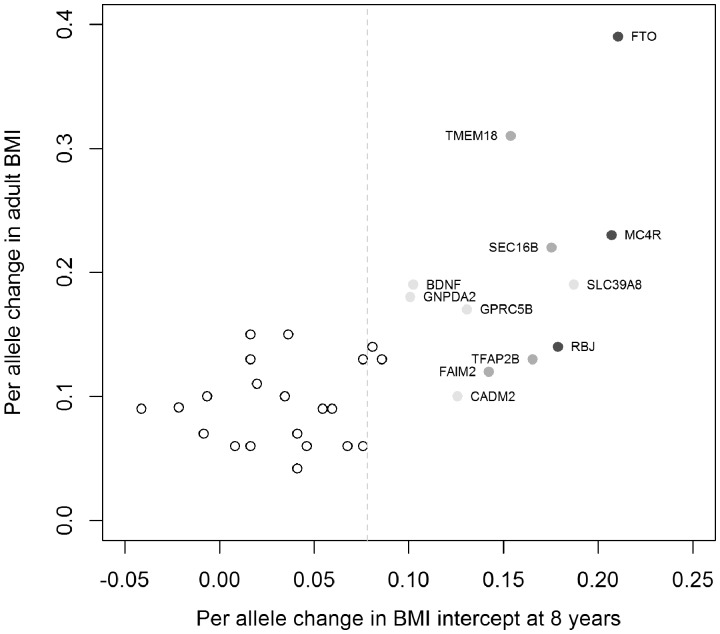
Association results of SNP effect at age 8 years for known adult BMI-associated loci. The y-axis displays the effect size from published meta-analyses8–10 and the x-axis displays the effect size from the meta-analysis presented in this paper of the BMI intercept at age 8. Effect sizes are aligned to the adult BMI-increasing allele. Colour indicates association P-values from the longitudinal model over childhood: dark grey = P < 5 × 10−8, medium grey = 5 × 10−8 ≤ P < 0.001, light grey = 0.001 ≤ P < 0.01, white = P ≥ 0.01. The dotted grey line indicates the mean effect size for the 33 SNPs in the longitudinal model parameters. The effect sizes from the meta-analysis were transformed from the log scale49 using an intercept of 2.80 and standard deviation of 0.057, for comparison with the adult effect sizes.